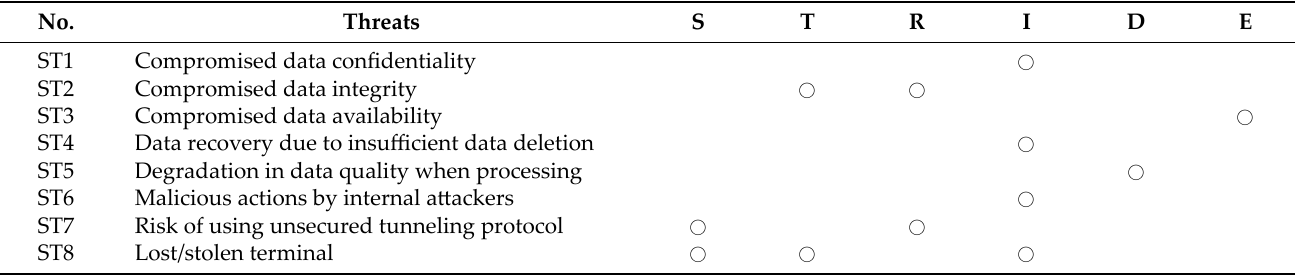
Table 6. Security threats and STRIDE mapping